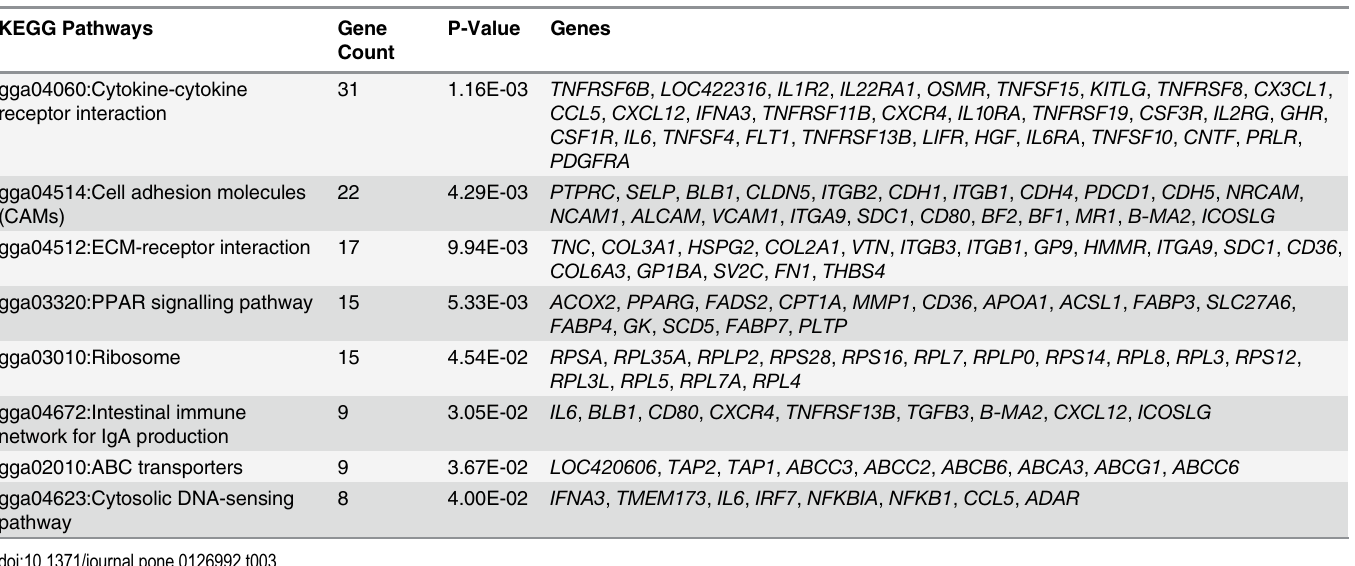
Table 3. KEGG pathway analyses in response to REV infection.